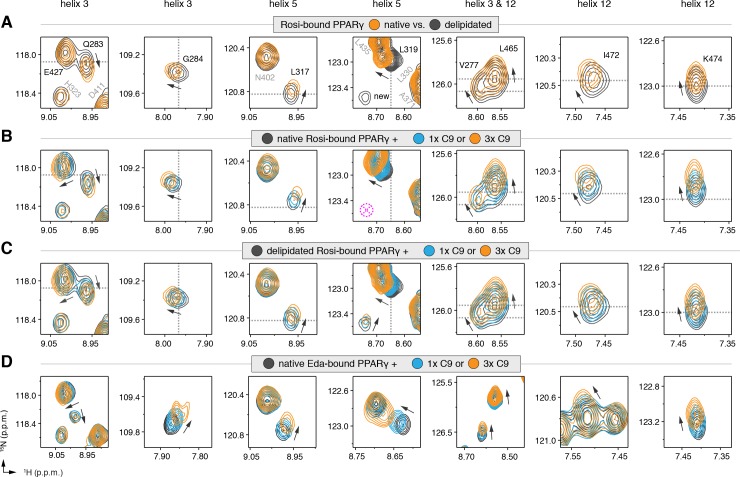
NMR confirms cobinding of exogenously added C9 and synthetic TZDs.Differential 2D [1H,15N]-TROSY-HSQC NMR data comparing (A) native vs. delipidated PPARγ LBD bound to rosiglitazone (two equiv.); (B) C9 added into native PPARγ LBD bound to rosiglitazone (two equiv.); (C) C9 added into delipidated PPARγ LBD bound to rosiglitazone (two equiv.); and (D) C9 added into native PPARγ LBD bound to edaglitazone (two equiv.). The dotted lines in panels A–C represent the vertical (1H chemical shift) or horizontal (15N chemical shift) position of the peaks in the delipidated form to illustrate how the peaks corresponding to the native, nondelipidated form shift ‘on path’ to changes caused by C9 binding. Black arrows denote the chemical shift changes; pink dotted circle/cross denotes a missing peak; and dotted lines denote the delipidated apo-PPARγ peak positions to illustrate the ‘on path’ transitions of native and C9-bound forms. Also see
Figure 5—figure supplement 1–5.